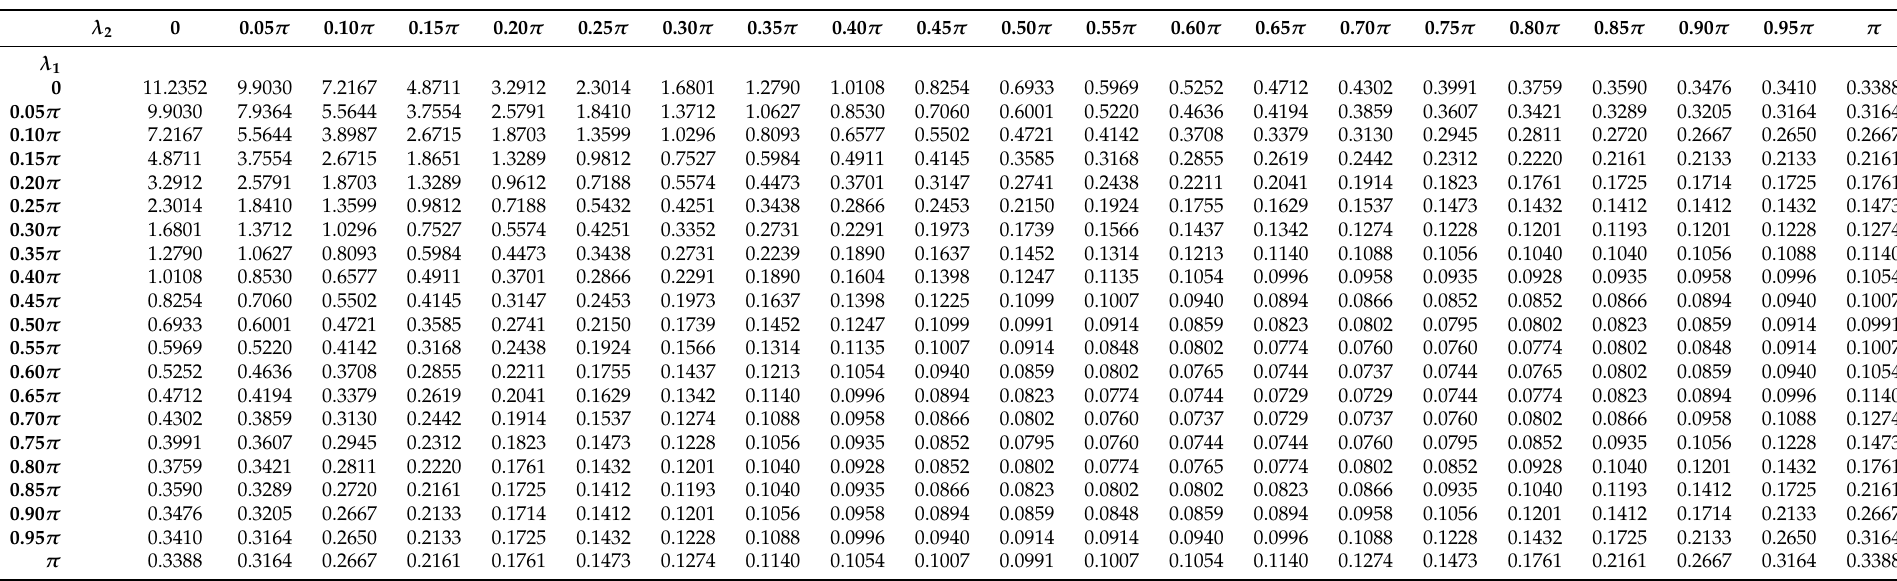
Table 1. Numerical values of theoretical bispectrum modulus of the DCGINAR(1) at µ = 1.8, α = 0.6 and θ =